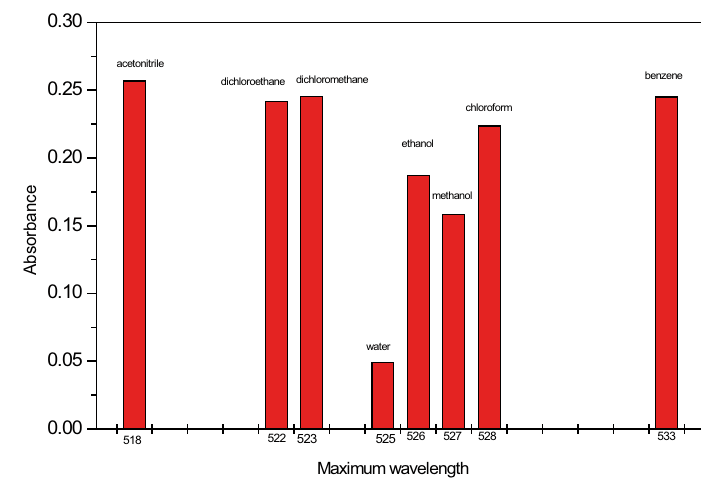
Figure 2. Effect of different solvents on charge transfer complex of 2×10 -4 M SU with 1×10 -3 M